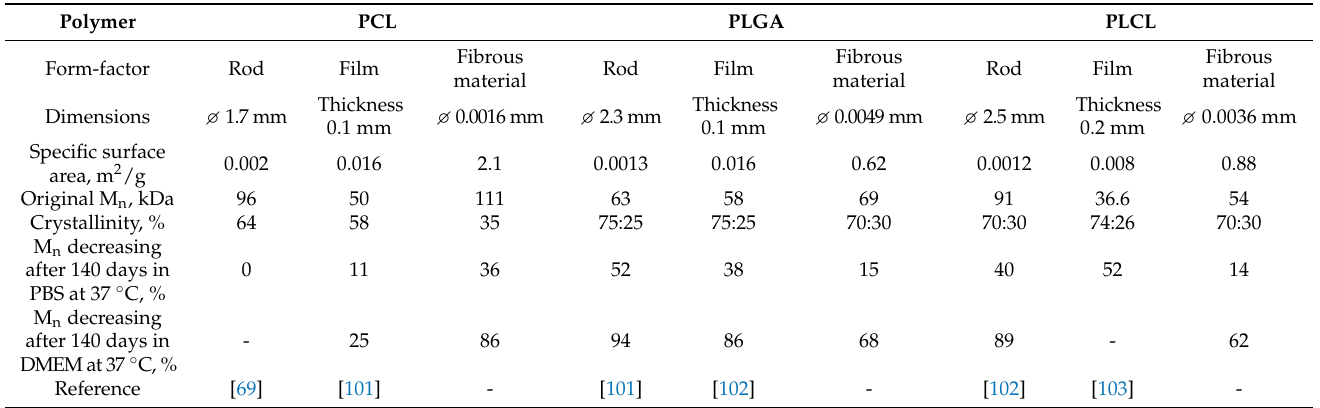
Table 3. Effect of the specific surface of PCL, PLGA, and PLCL scaffolds on